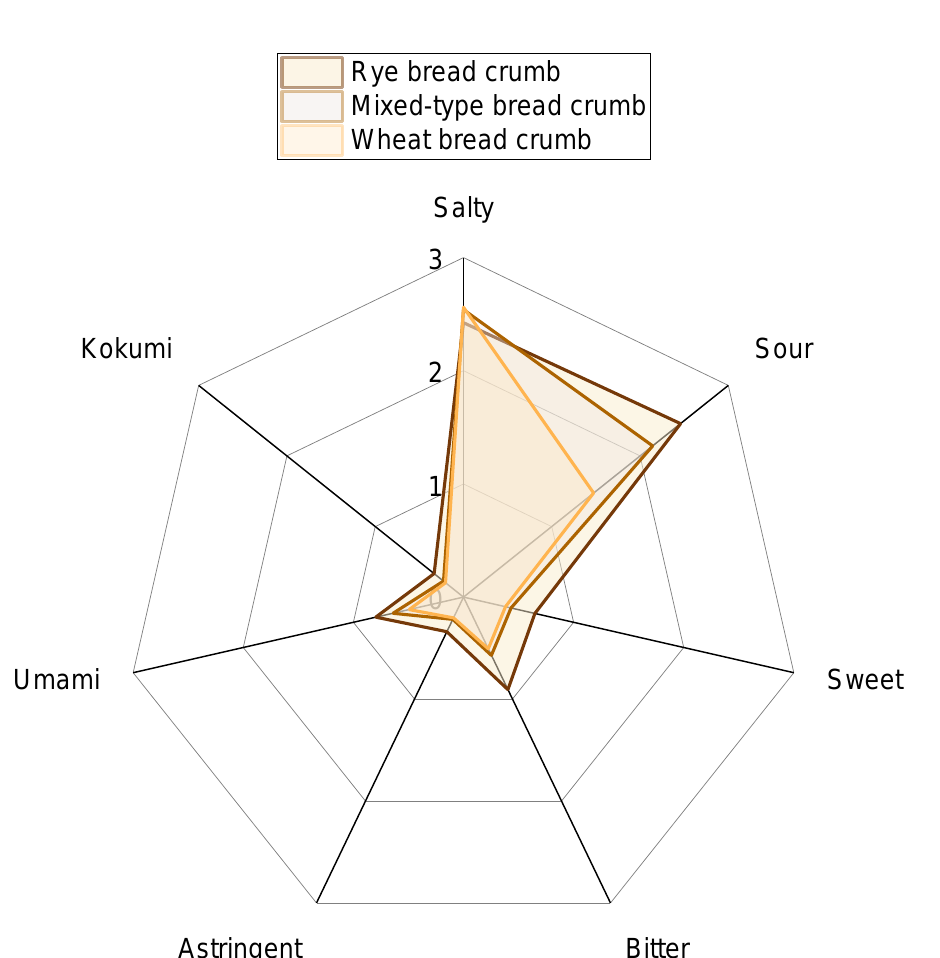
Figure 1. Comparative taste profile analysis of the crumbs of rye bread, mixed-type bread, and wheat bread. The intensity of each taste quality was rated on a linear scale from 0 (not perceivable) to 5 (strongly perceivable) by the trained sensory panelists ( n = 16 for rye bread crumb, n = 17 for mixed-type and wheat bread crumb).